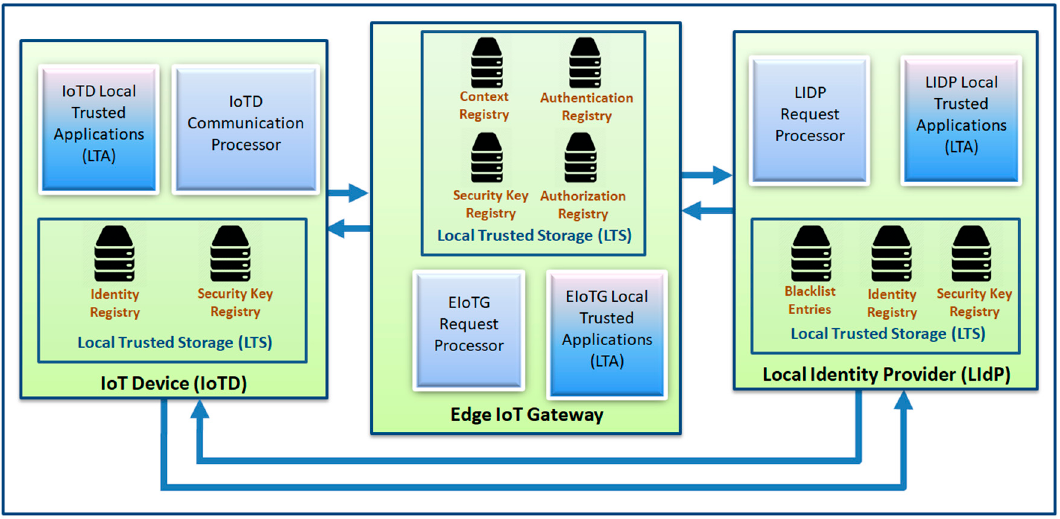
Figure 8. Internal architecture of security communication modules in IoTD, EIoTG and LIdP.